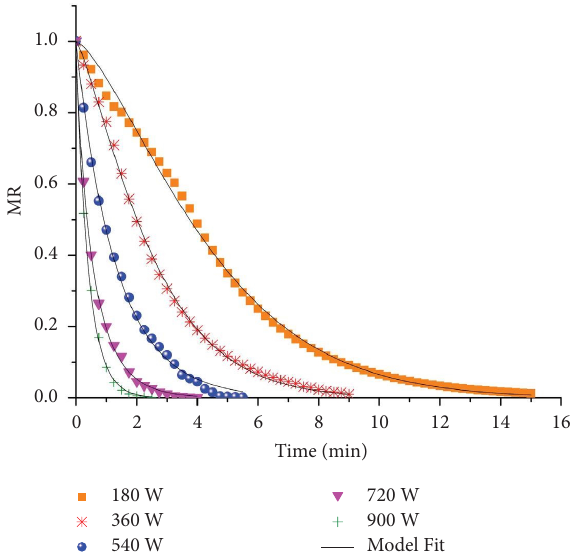
Figure 2: Variation of moisture ratio during microwave drying of Stevia leaves at diferent powers.